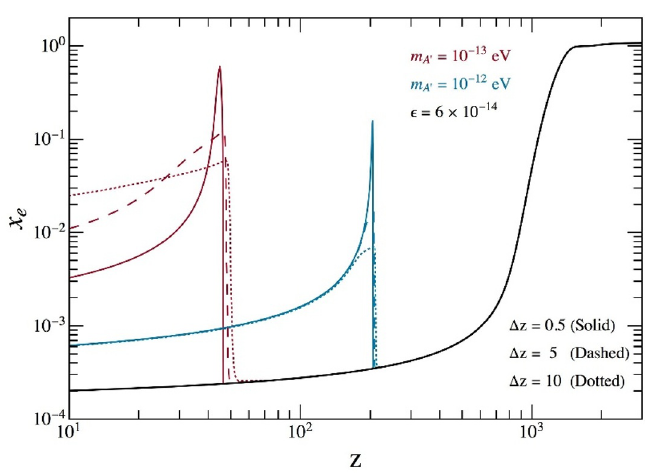
Figure 10 . Change in x e assuming energy is injected following a Gaussian distribution in z with (cid:1) z = 0 : 5, 5, or 10, and for two masses and choices of mixing. Computation includes collisional ionization as described in ref.